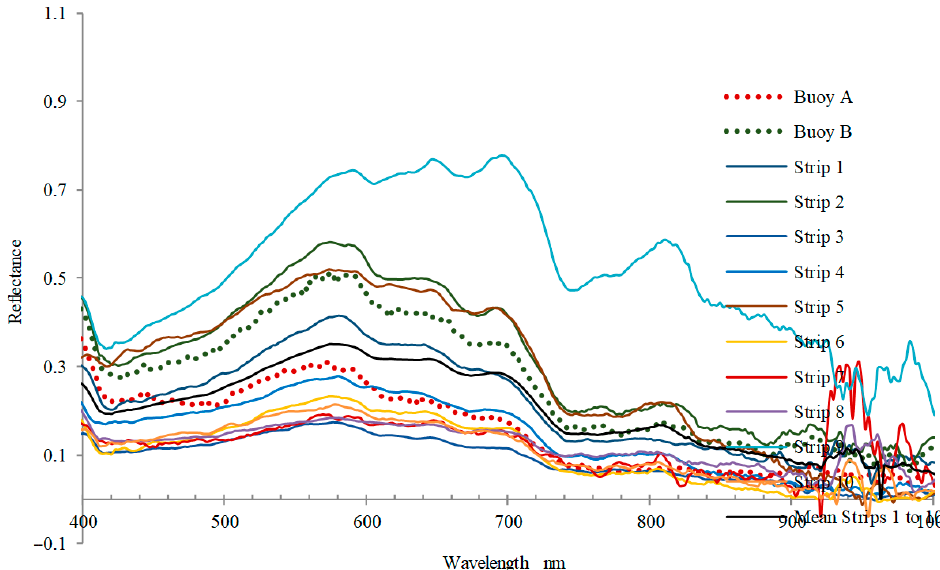
Figure 7. Comparison of mean reflectance between the data of two buoy spectrometers and 10 strips of UAV.